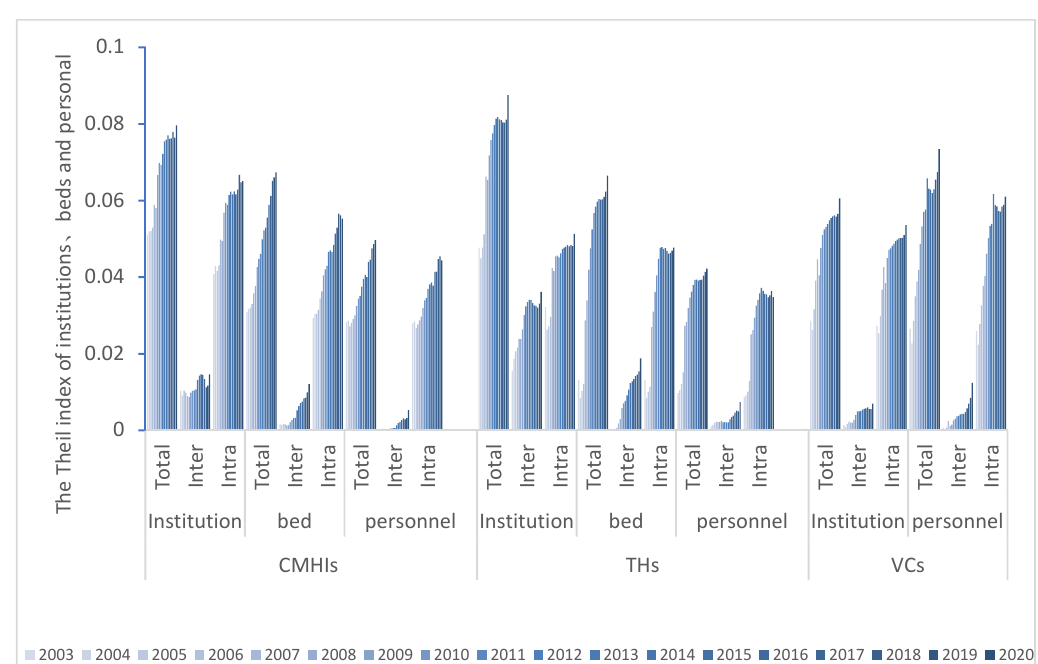
Institution bed personnel Institution personnel